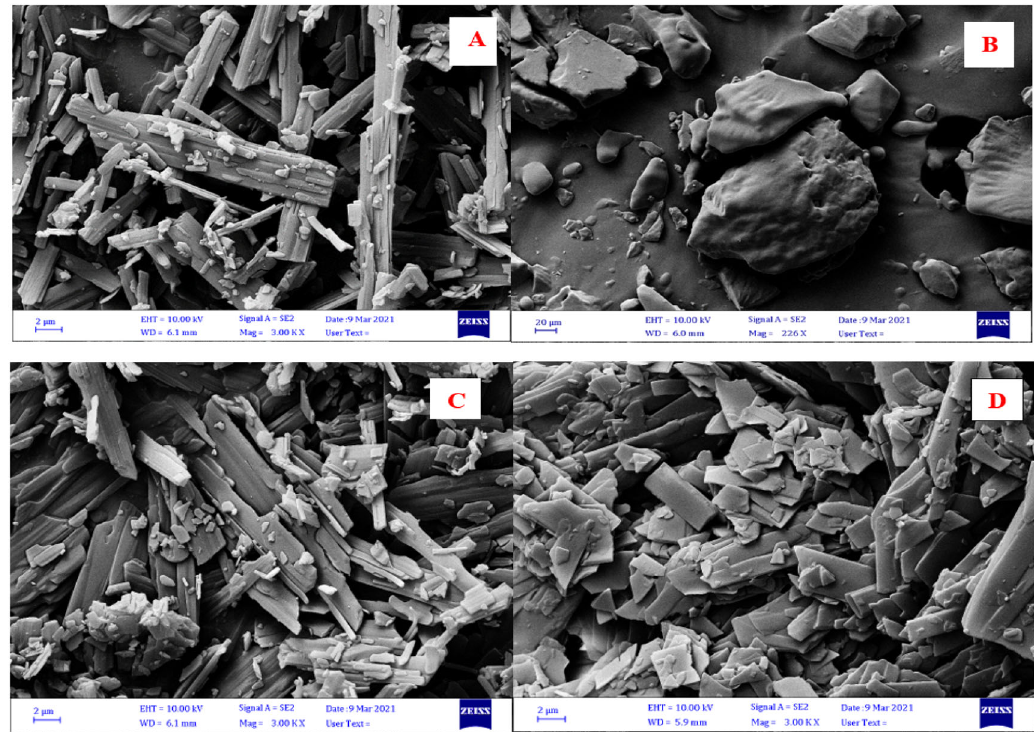
Figure 7. FESEM images of (A) VEM, (B) PE, (C) physical mixture of VEM and PE, and (D)